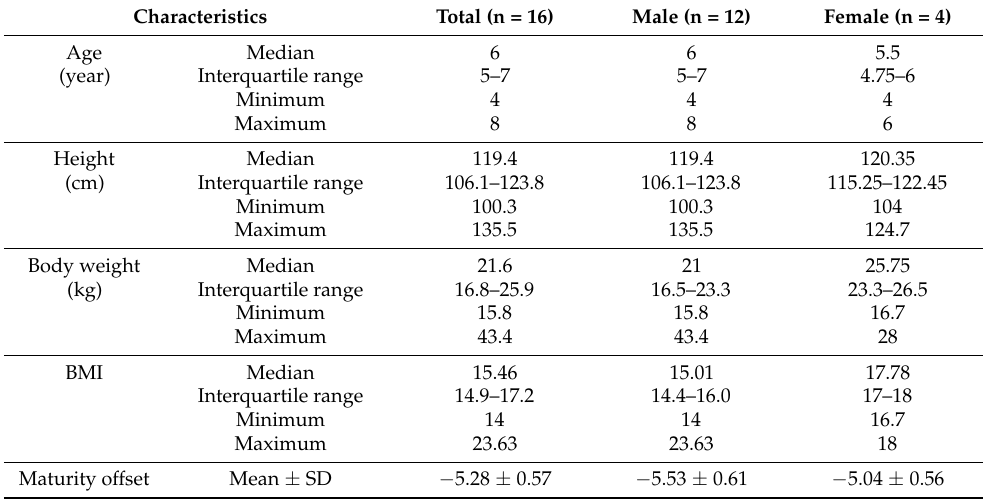
Table 2. Demographic characteristics of participants according to the gender.